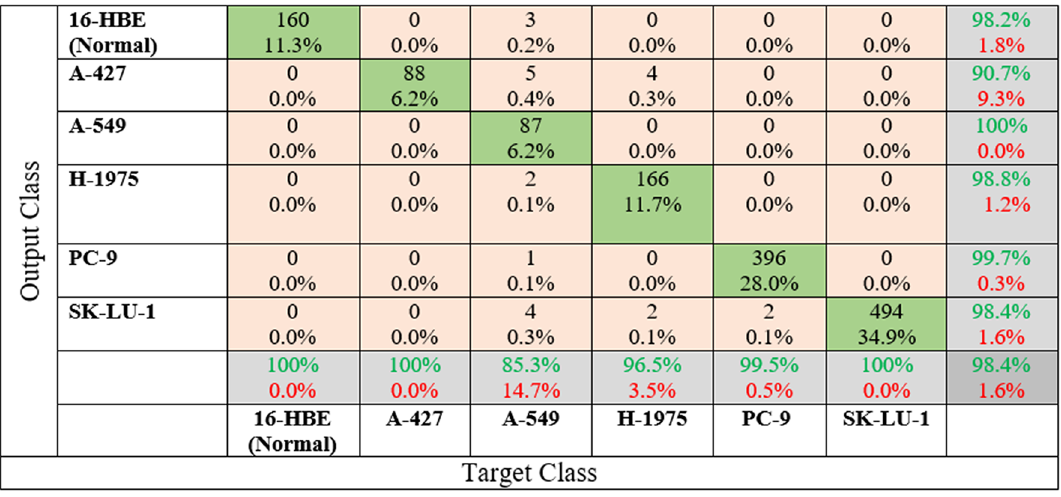
Figure 3. Confusion matrix for lung cancer cell detection resulted from ResNet18. Rows of the matrix represents the number of instances in a predicted class (upper number) as well as the percentage of correctly or incorrectly classified observations for each true class (down number), while each column represents the instances in an actual class. The information of class-wise precisions and recalls are summarized at the end of each rows and columns respectively with green color, while the corresponding error rates are specified with red color.